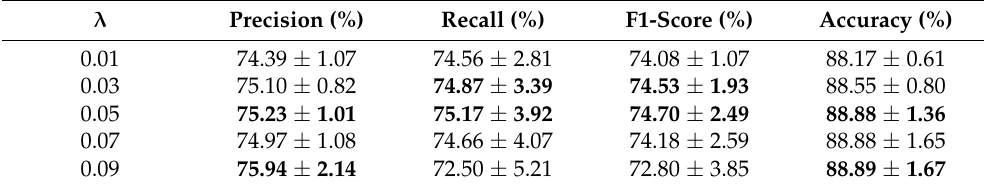
Table 4. Experimental results (mean ± std) of FedAAR with different weighting coefficients λ of the prototype guidance regularization loss. The best two results for each metric are highlighted in